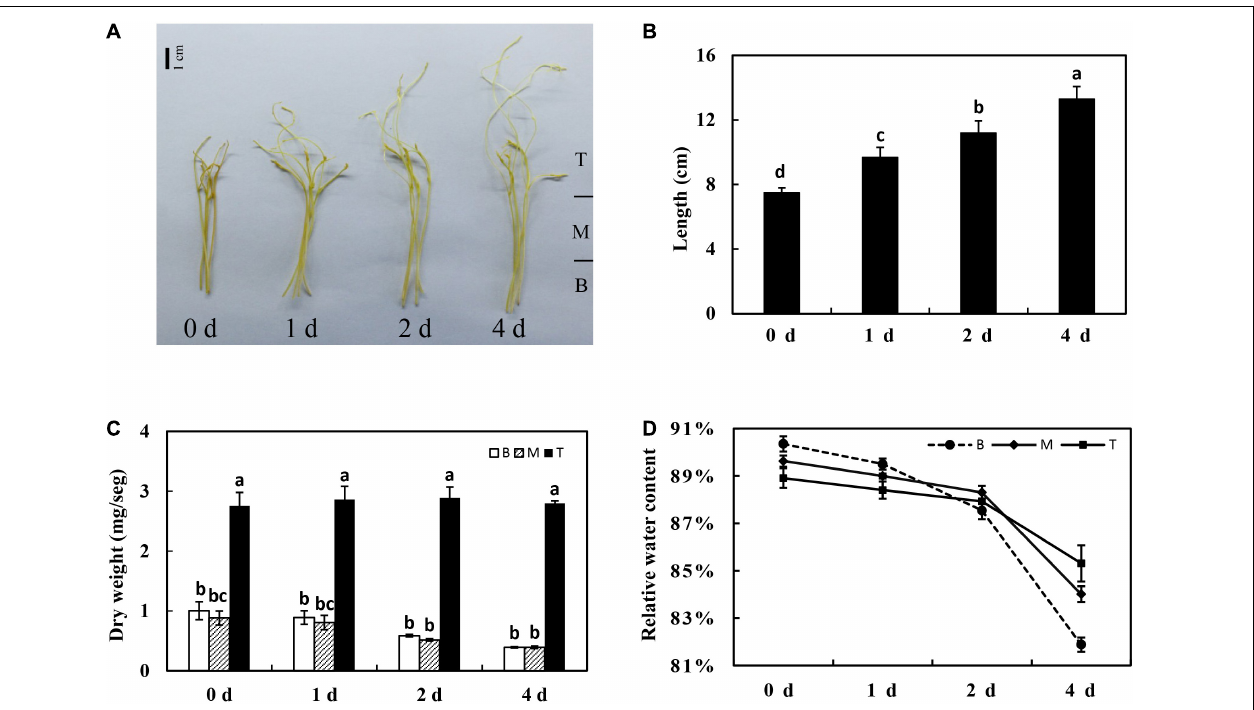
FIGURE 1 | Physiological characteristics of the in vitro dodder shoots growth. Morphology (A) , length (B) , shoot dry weight kinetics (C) , and relative water content (D) of in vitro dodder shoots on days 0, 1, 2, and 4 after excised from host (B, basal stems; M, middle stems; T, shoot tips). Vertical bars are standard deviation of the mean ( n = 3). Bars marked with the same letter represent no significant difference between each other protected with Fisher’s least significant difference (LSD) at P <